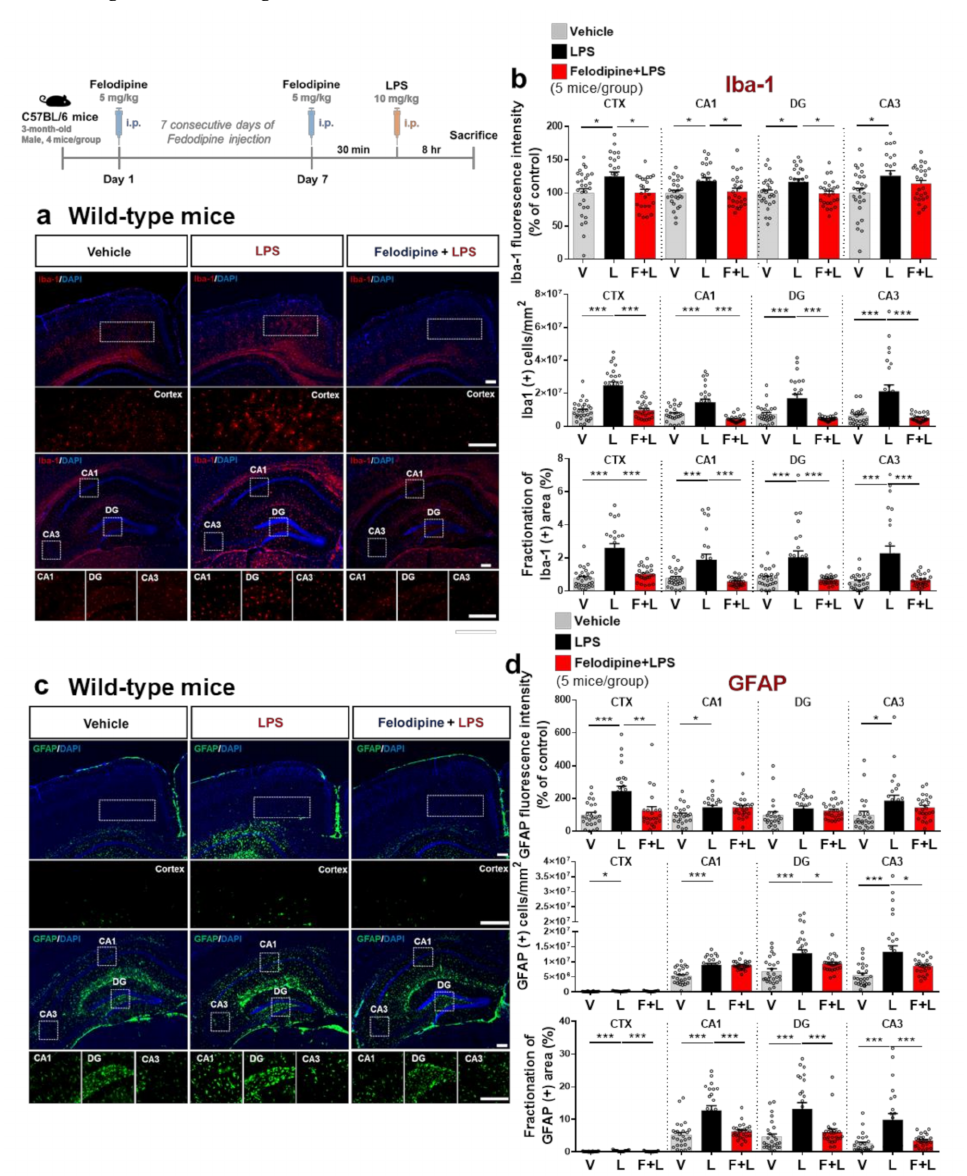
Figure 6. Daily administration of felodipine for 7 days suppresses LPS-stimulated microgliosis and astrogliosis in the brain in C57BL/6 mice. ( a , c ) Immunofluorescence staining of microglial and astroglial expression in brain slices from C57BL/6 mice injected daily with vehicle (5% Tween-20 + 5% PEG300 in saline) or felodipine (5 mg/kg, i.p.) for 7 days, followed by injection of LPS (10 mg/kg, i.p.) or PBS on day 7. ( b , d ) Quantification of data from ( a , c ) (n = 5 mice/group. Vehicle, n = 26 brain slices; LPS, n = 24 brain slices; felodipine+LPS, n = 26 brain slices). * p < 0.05, ** p < 0.01, *** p < 0.001, scale bar = 100 µ M. V: vehicle; L: LPS; F or Felodi: